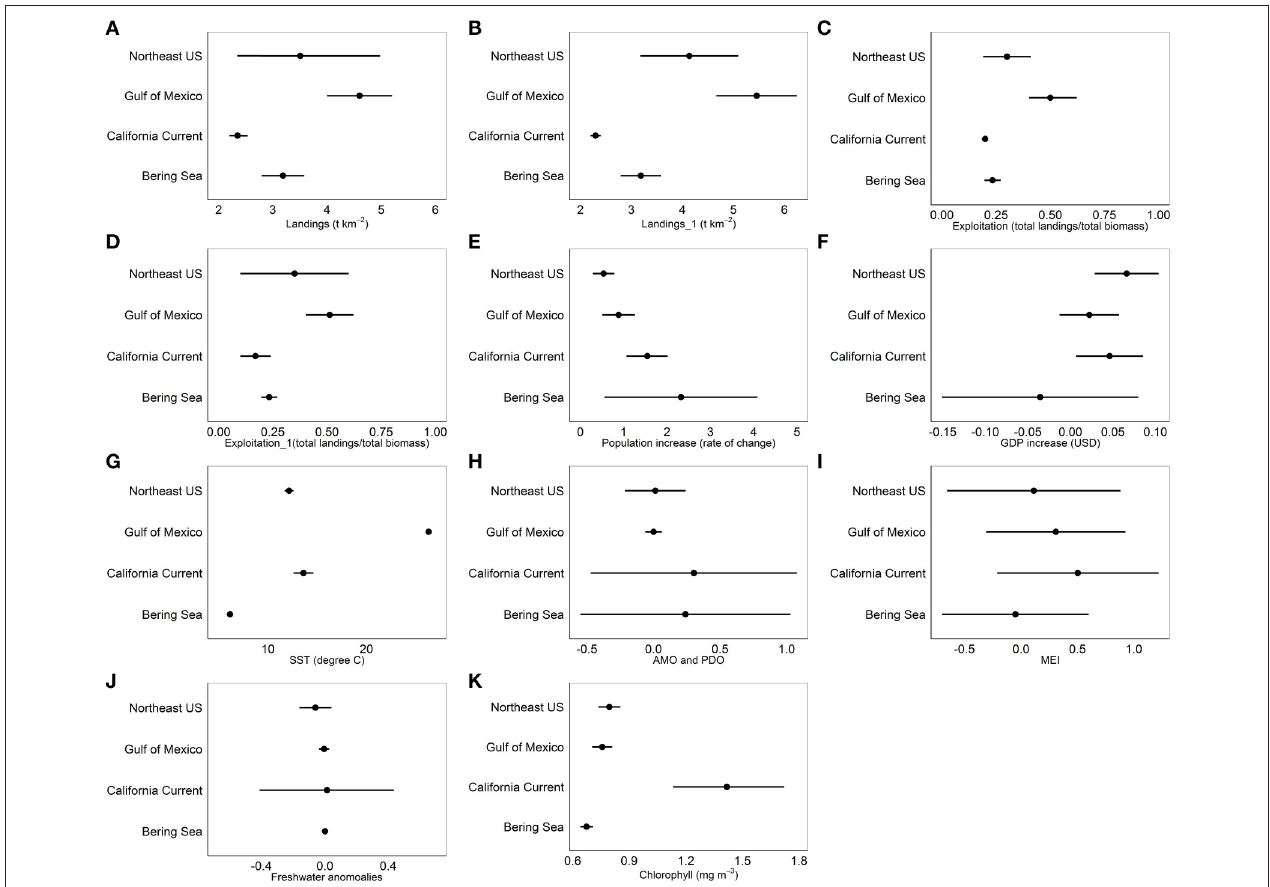
FIGURE 3 | Mean thresholds and 95% CI ranges for (A) Landings, (B) 1 year lagged landings, (C) Exploitation, (D) 1 year lagged exploitation, (E) Population increase of the coastal community, (F) Gross Domestic Product of the coastal community, (G) Sea Surface Temperature, (H) Atlantic Multidecadal Oscillation and Pacific Decadal Oscillation, (I) Multivariate ENSO Index, (J) Freshwater anomalies, and (K) Chlorophyll concentration from the gradient forest analysis for Alaska (Bering Sea), California Current, Northeast US and Gulf of